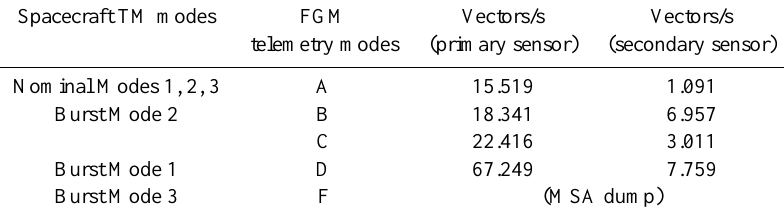
Table 2. Magnetic vectors telemetered to ground for the operating modes of